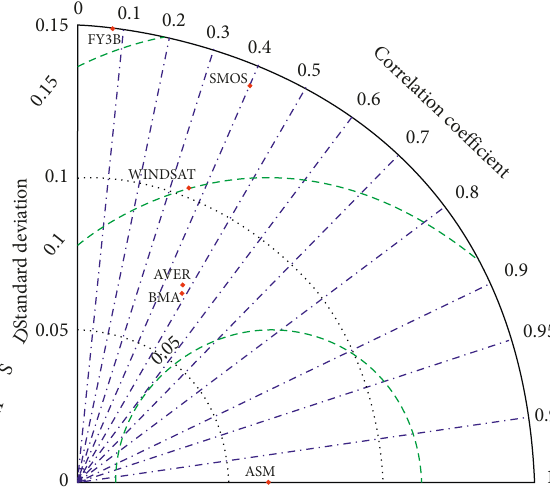
Figure 3: Taylor diagram for Northeast China.